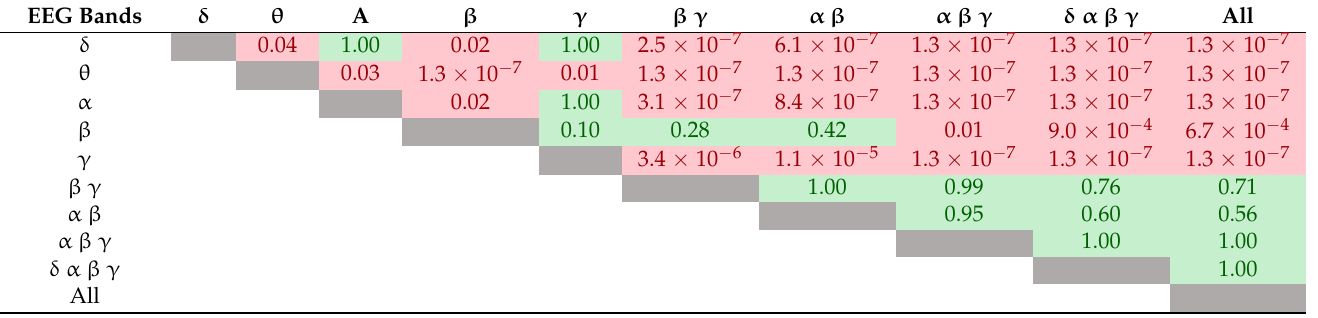
Table 6. p -values F (9, 280) obtained using pair-wise Tukey’s honestly significant difference procedure between different frequency bands. The results for the first scenario when training and testing feature set vectors were from the same recording. The red indicate a statistical difference in accuracy, the green, that there is no enough evidence for it.